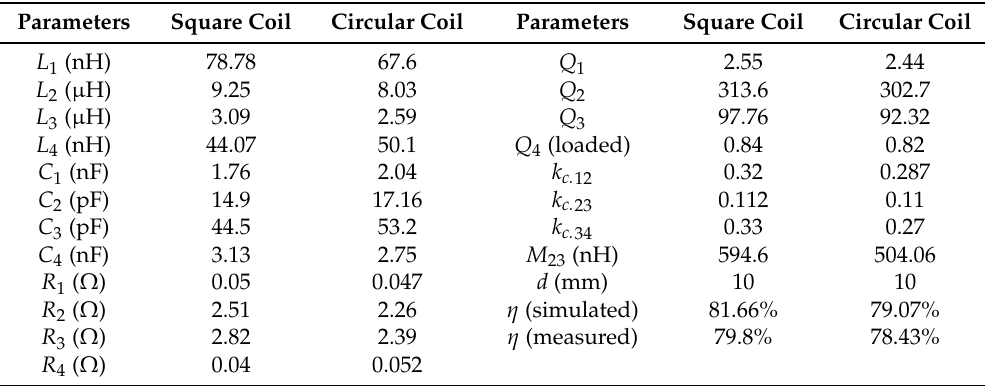
Table 4. Electrical